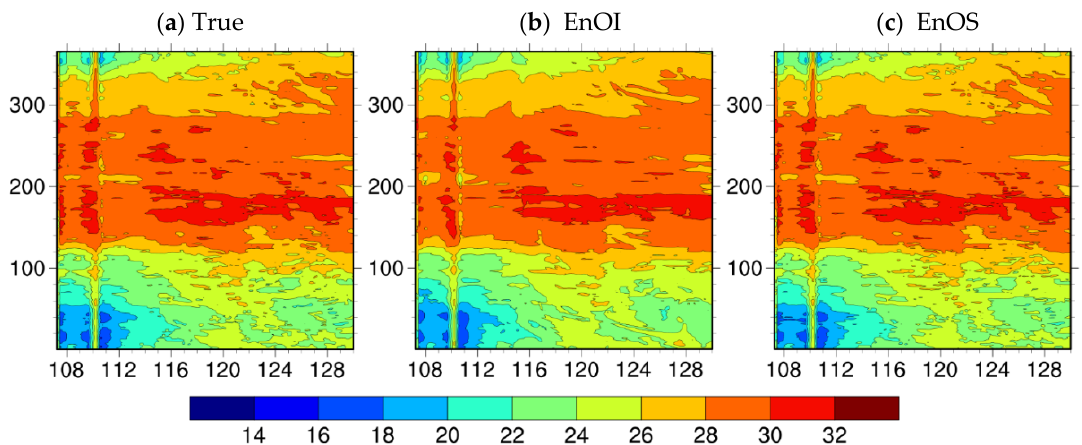
Figure 10. Hovmöller diagrams of fluctuations over time on the longitude line at 21° N. In each panel, the horizontal axis shows the latitudinal range of the ocean and the vertical axis shows the time range of 1 to 365 days. The corresponding results of the three figures are from the target field, EnOI, and EnOS.